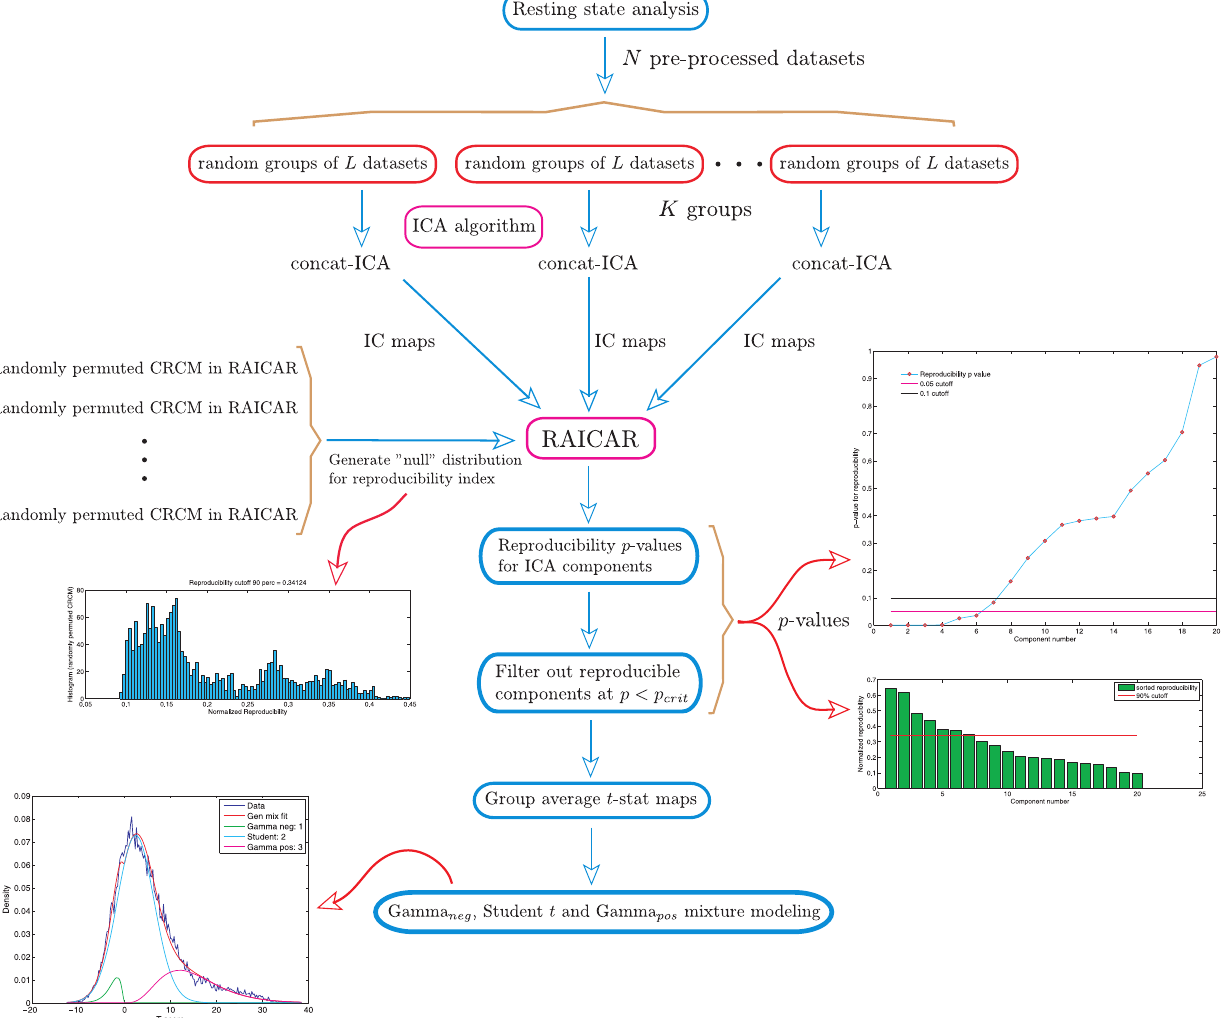
Figure 4. Flowchart for a group ICA based RAICAR-N analysis. The N single subject data sets are first pre-processed and subsequently bootstrapped to create K groups, each group containing L distinct subjects. Each group of L subjects is submitted to a temporal concatenation group ICA analysis. The resulting IC maps (either raw ICs or ICs scaled by noise standard deviation) are subjected to a RAICAR analysis. The cross- realization cross correlation matrix (CRCM) is randomly permuted multiple times: G ? G ( g , g ) where g is a random permutation of integers from 1, ... , Kn C . The permuted CRCMs are subjected to a RAICAR analysis to generate a realization of reproducibility values under the ‘‘null’’ hypothesis. The computed ‘‘null’’ distribution of reproducibility values is used to assign p values to the observed reproducibility of the original RAICAR run. Finally, reproducible ICs are averaged using a random effects analysis and the resulting t -statistic images are subjected to Gamma neg , Student t and Gamma pos mixture modeling.